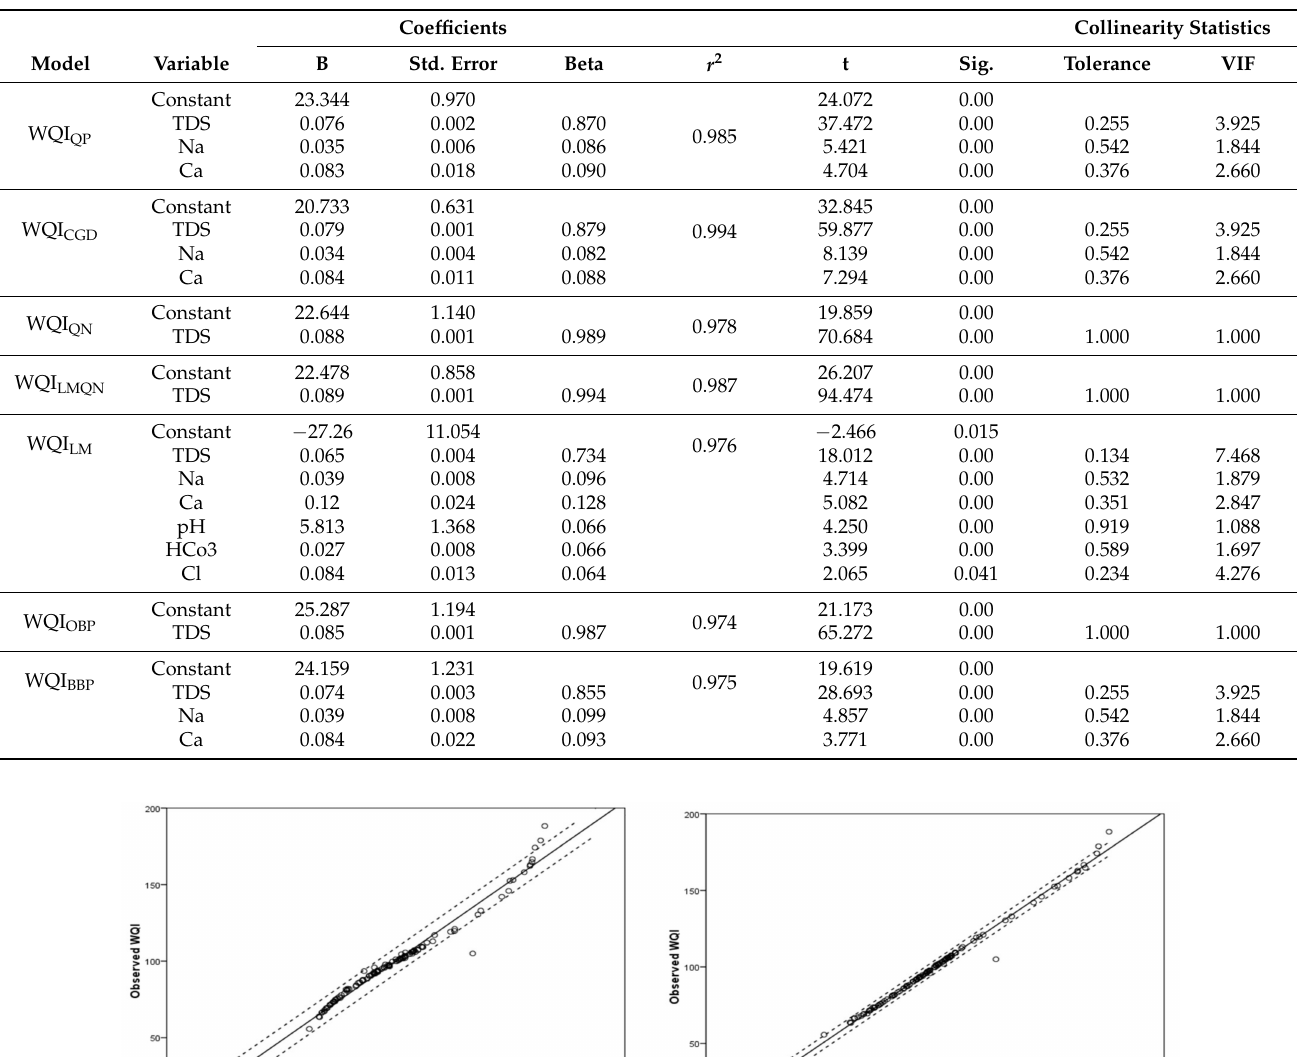
Table 5. Statistics of the ANN training algorithms-based MLR models.